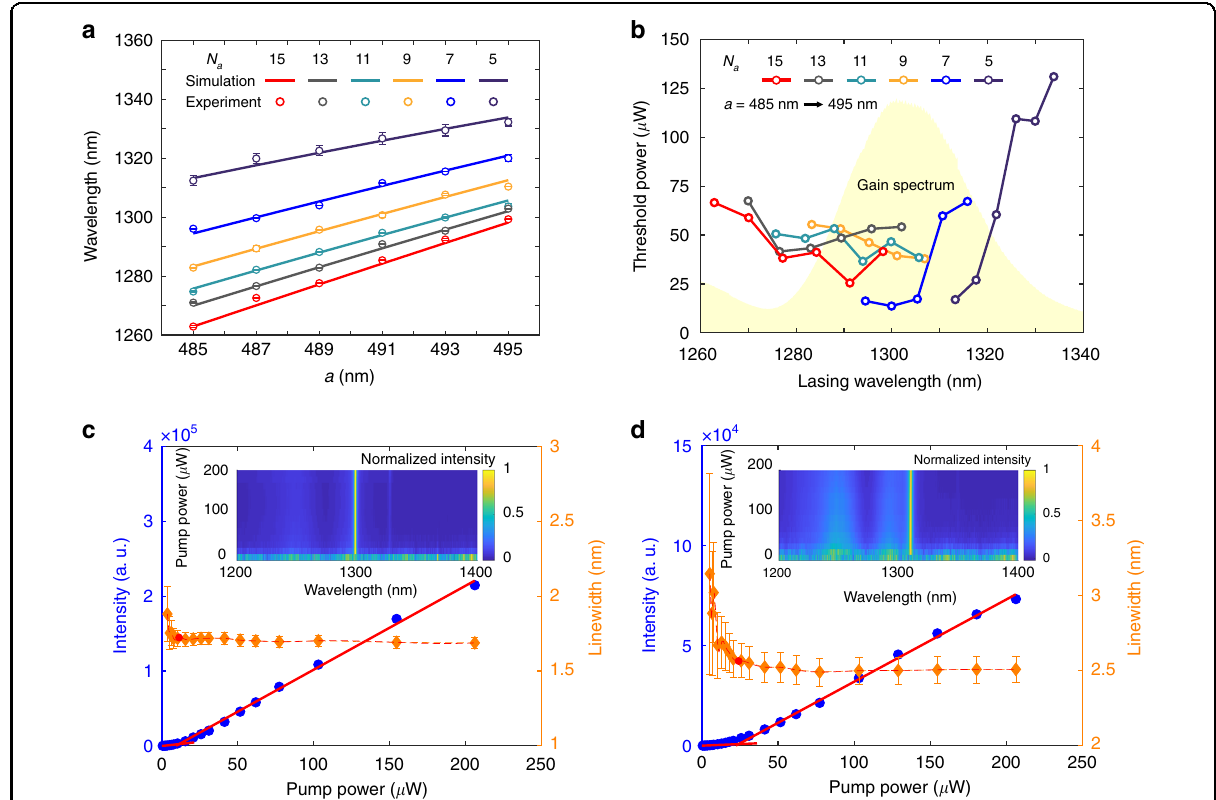
Fig. 3 Wavelength tunability and single-mode lasing with small footprint. a The typical measured lasing wavelengths of M 11 mode in the cavities of different sizes and different periods agree well with theoretical resonant wavelengths. A wide tuning range of nearly 80 nm is achieved, with highly predictable wavelengths. b The measured threshold power of the lasers with different a and N a . The yellow shaded region shows the relative magnitude of the QD gain spectrum. The threshold increases markedly for wavelengths longer than 1320 nm, where the optical gain of the QD ground state fall off sharply. On the short wavelength side, the threshold rises slowly as some gain results from the excited state of the QDs. The evolution of the collected emission intensity, linewidth as well as intensity spectrum as a function of pump power of the samples with a = 487 nm, N a = 7 ( c ) and a = 485 nm, N a = 5 ( d